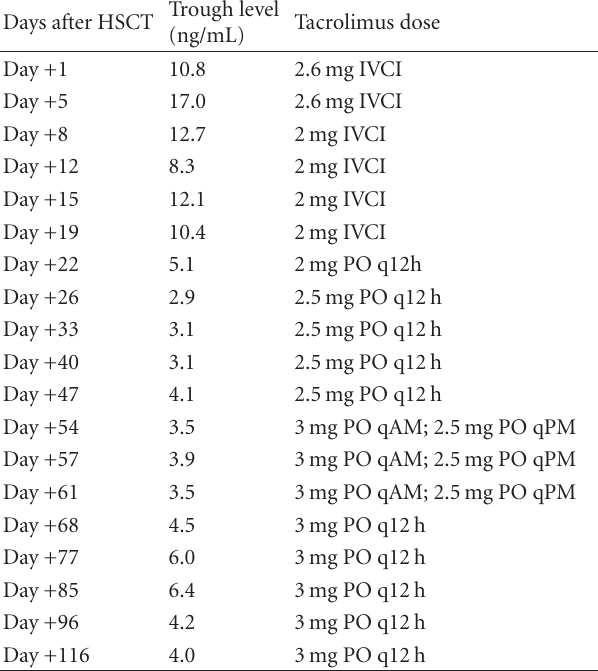
Table 2: Tacrolimus trough levels by dose. Trough level Days after HSCT